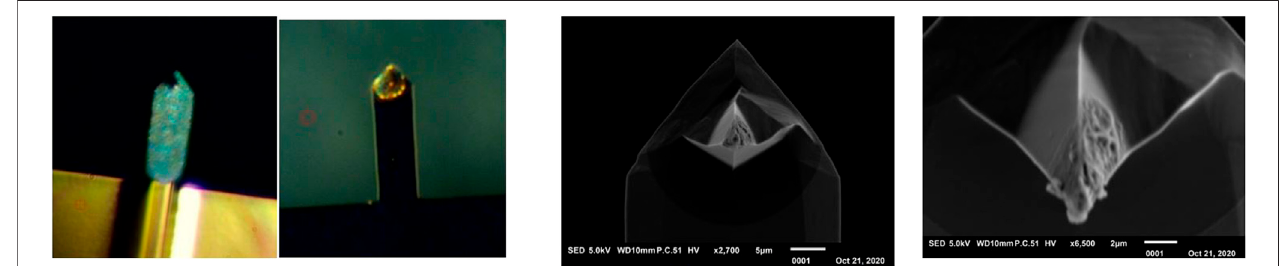
FIGURE 5 | Left: Lithiation covering the cantilever (EC/DMC based electrolyte). Right: Lithiation of the tip by alloying (Ionic Liquid electrolyte).